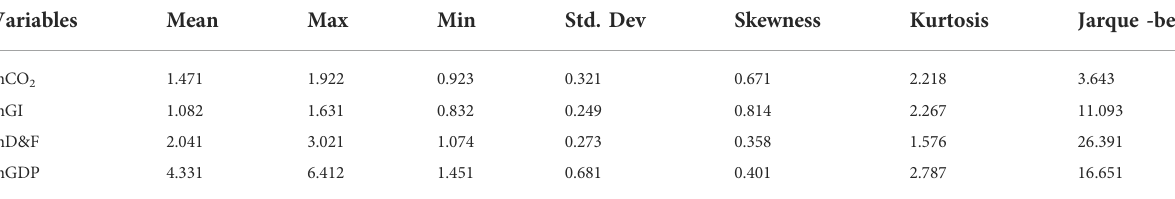
TABLE 3 Descriptive Statistics results.